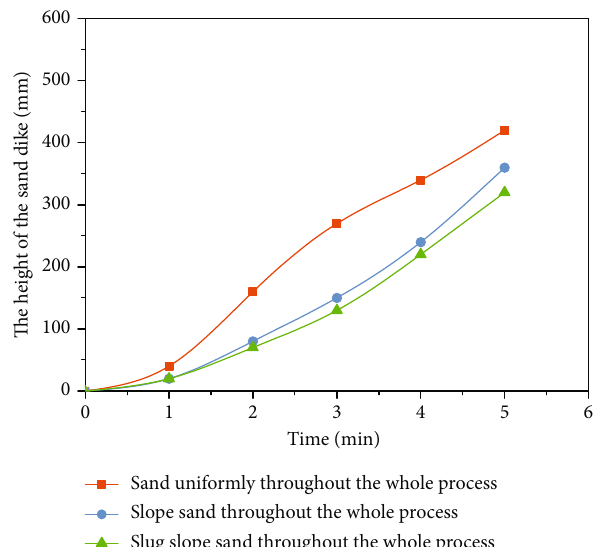
Figure 11: The height of the sand dike in sand carrying by slickwater with di ff erent proppant pumping schedules.